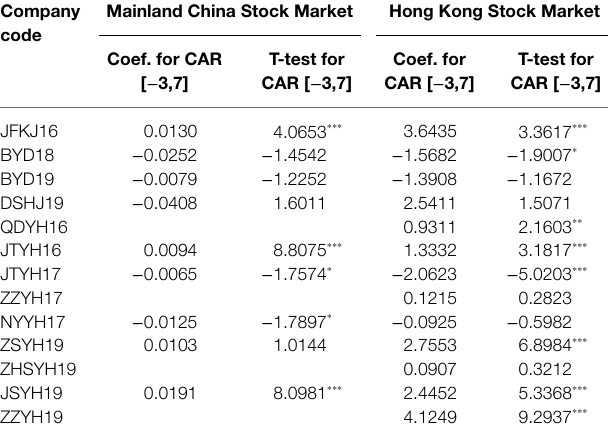
TABLE 4 | Chinese firms listed in both stock